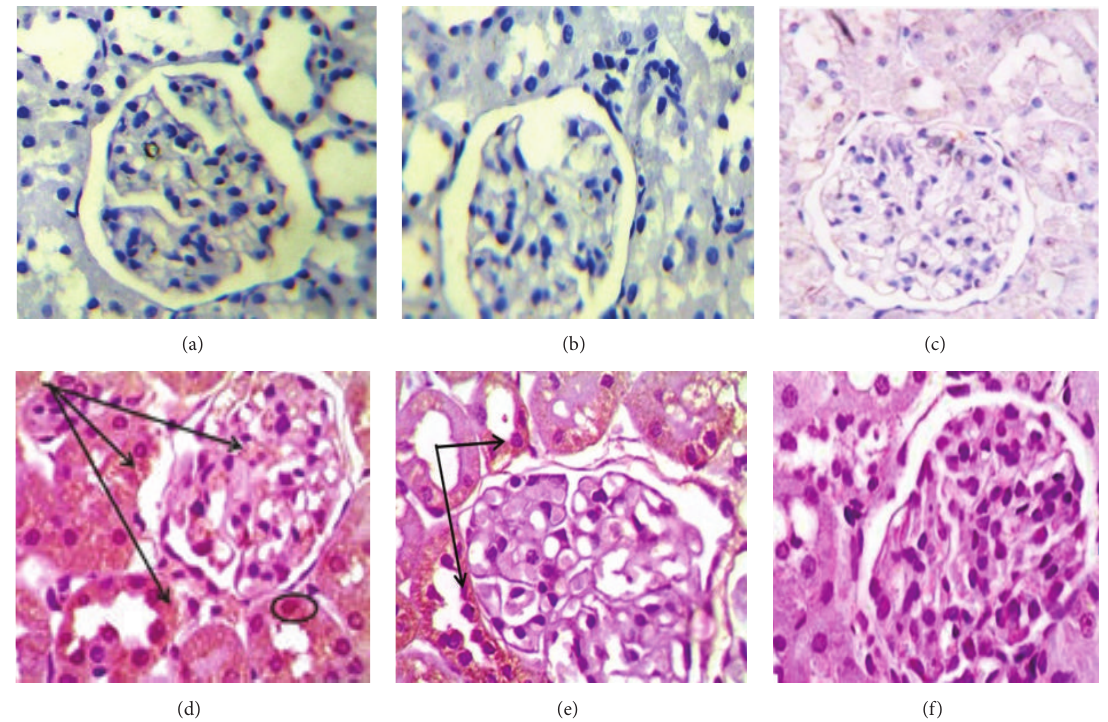
Figure 2: Photomicrographs of renal cortex immune stained for caspase-3 of (a), (b), and (c), control, DLD, and DHD groups, respectively, showing negative immunoreactivity. (d) DOX treated group showing extensive expression in the renal glomeruli and renal tubules. (e) DOX/DLD group showing moderate expression within the glomeruli and the renal tubules. (f) DOX/DHD group showed marked improvement with no expression in glomeruli and renal tubules. The expression is mainly cytoplasmic, but with some immunopositive nuclei. Immunohistochemistry counter stained with H&E × 400. Bar = 20 𝜇 .